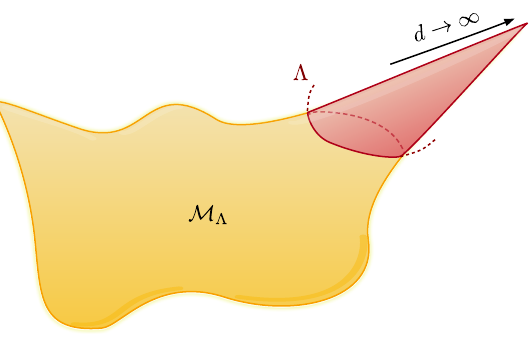
Figure 2 . The moduli space M Λ accessible within an EFT characterised by a cutoff Λ